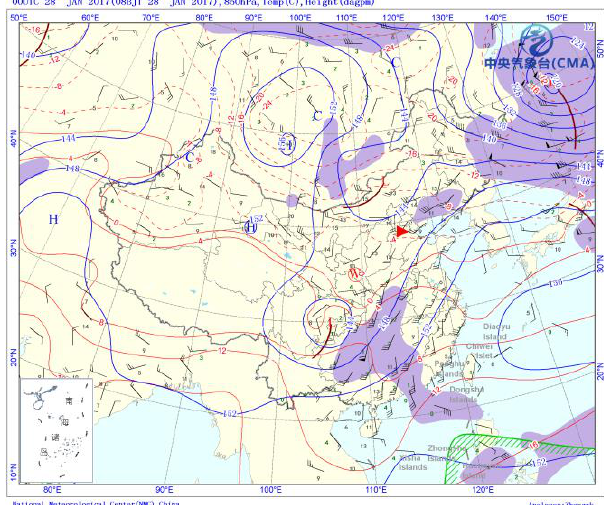
Figure 2. The map of potential heights along with winds, temperature, and pressure at 850 hPa altitude in China on 0000 UTC (0800 LT) of January 28, 2017. The red triangle represents the Baoding City. The figure is downloaded from National Meteorological Center, China.